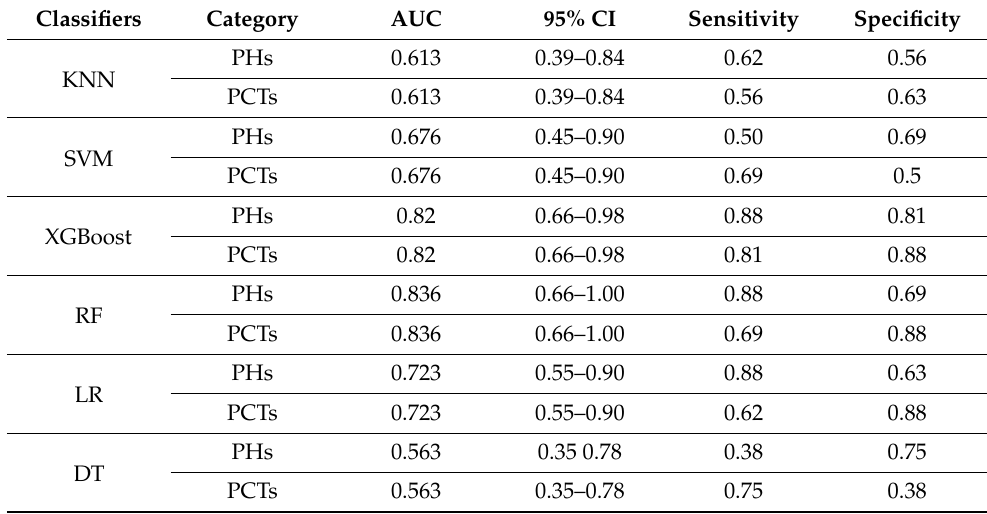
Table 4. ROC outcomes for six machine learning classifiers of the test set and the second